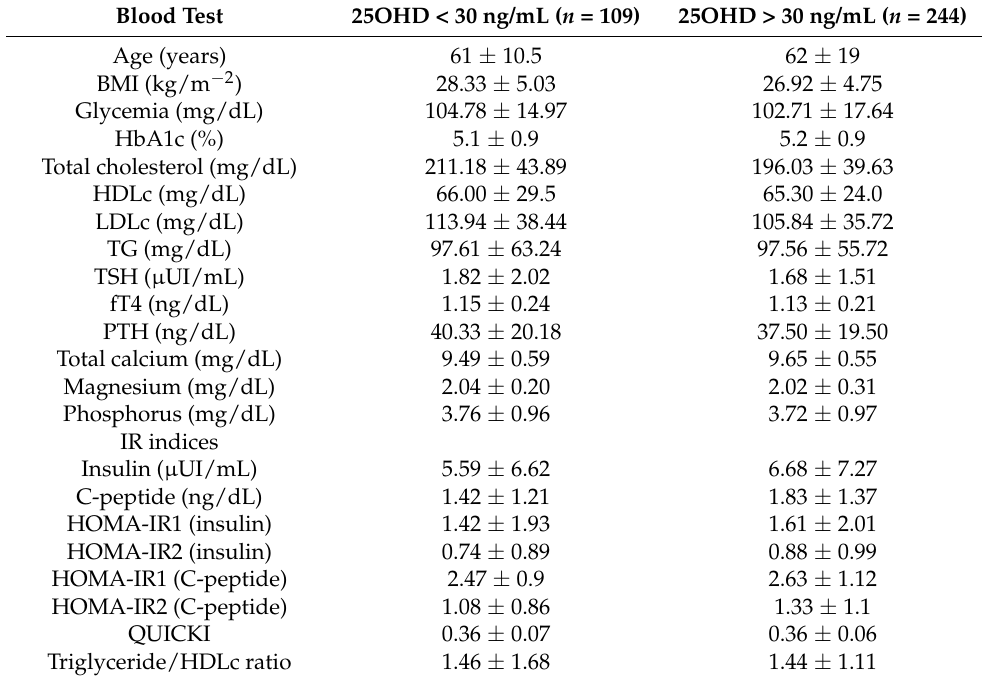
Table 1. Population characteristics based on 25-hydroxyvitamin D (25OHD) levels.